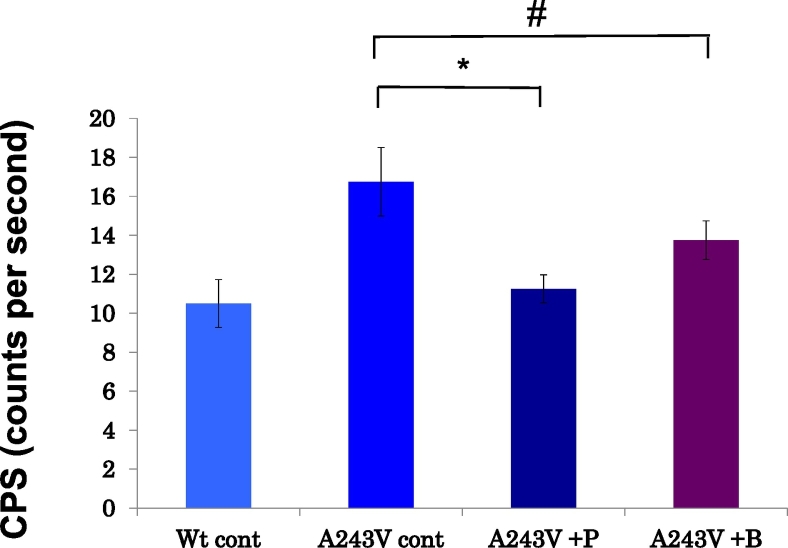
The results of an examination as to whether or not the correction of localization reduced the ER stress and the ER stress activity as determined based on the luciferase assay of PLP1A243V after the addition of piracetam and benserazide and PLP1WT are shown. The CPS is the index of the ER stress activity that reflects the luciferase activity of a spliced XBP1 RNA. Piracetam significantly decreased the ER stress activity (P = 0.04). Although no significant difference was noted, benserazide tended to reduce the ER stress (P = 0.07). *P < 0.05. #P = 0.07. Error bar: mean ± SE.